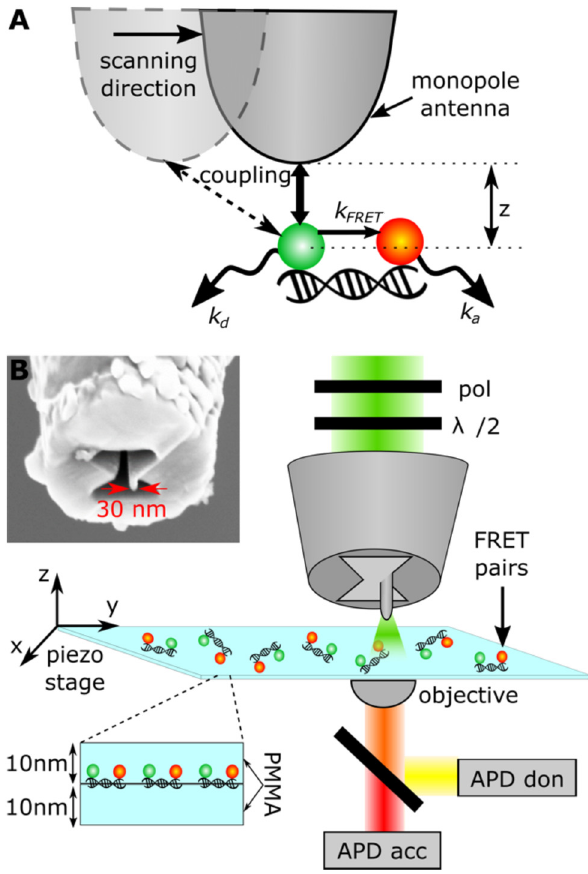
Figure 1: ( A) Schematic depiction of the Förster resonance energy transfer (FRET) process in presence of a scanning antenna, showing the different rates involved. An optical nanoantenna (bowtie with monopole) positioned at a z distance above the sample scans laterally individual FRET pairs. The coupling of the monopole antenna to the emitters depends on their relative 3D position and affects the donor decay rate k d and k FRET , modulating FRET ef fi ciency and acceptor emission. (B) Schematic of the near- fi eld scanning optical microscopy (NSOM) setup, with an aluminium-based optical antenna probe placed in close proximity to the sample, where the FRET pairs are immobilized, and the subsequent detection scheme. The upper inset shows a scanning electron microscope (SEM) image of a representative hybrid antenna probe supporting a monopole with an apex of 30 nm in diameter. The lower inset shows a cross- section of the sample, with the FRET pairs immobilized between two 10 nm think-poly (methyl methacrylate (PMMA) between the FRET pairs and the antenna is between 15 and 20 nm.